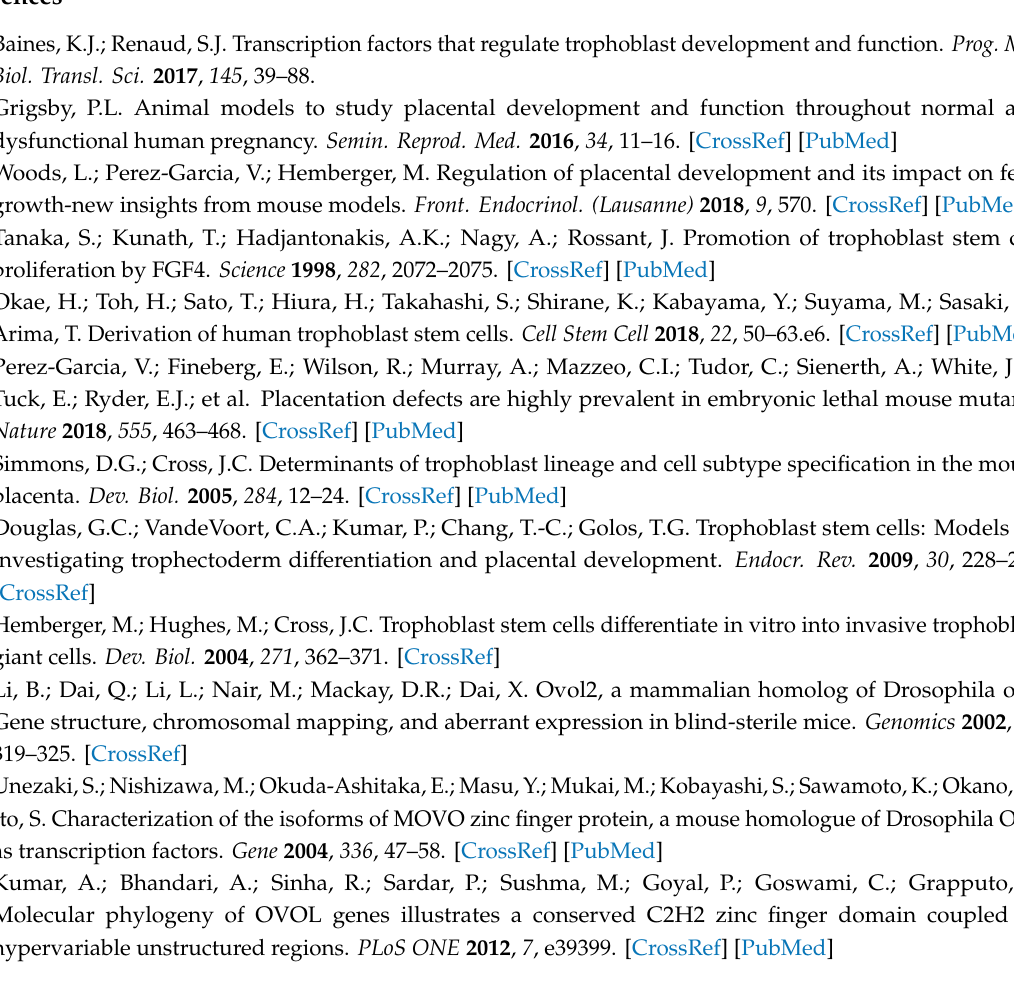
Figure S1: Quantitative analysis of Ovol2 expression in mouse placenta and embryo throughout gestation, Figure S2: Verification of OVOL2 antibody, Figure S3: Transcript analysis of mouse TS cells cultured under stem conditions versus two di ff erentiation